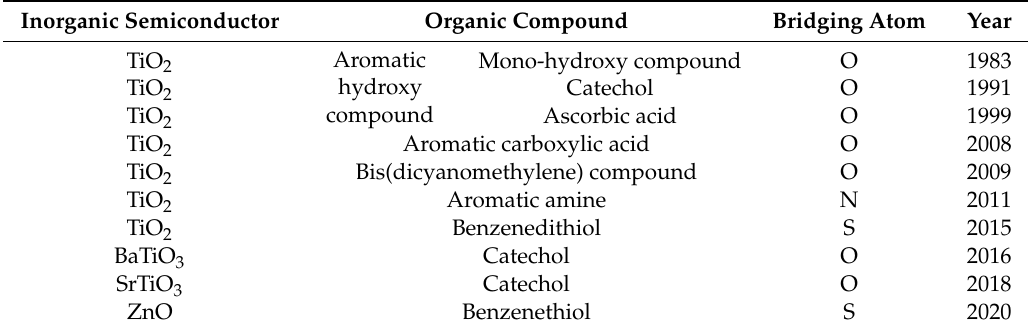
Table 1. Representative organic-inorganic semiconductor complexes for ICTT, bridging atoms, and the year of the first report for each organic-inorganic complex. Inorganic Semiconductor Organic Compound Bridging Atom TiO 2